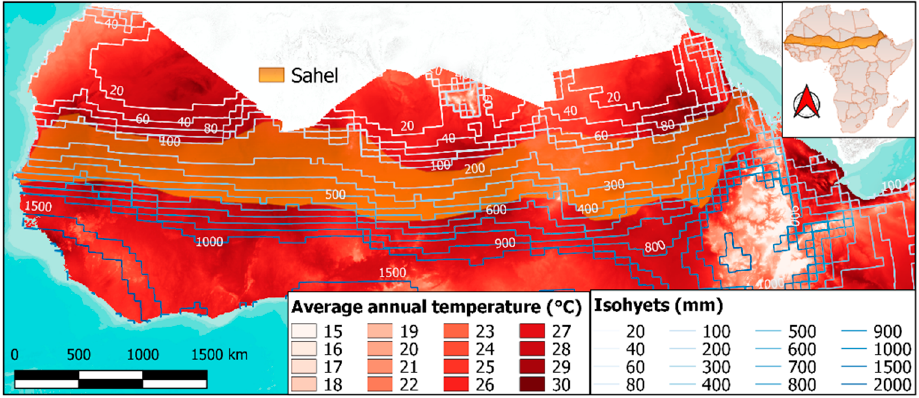
Figure 1. Geolocation of the Sahelian strip. Long-term climate data: average temperature (1970–2000) and isohyets (1960–2014) of the sub-Saharan area [37,42].